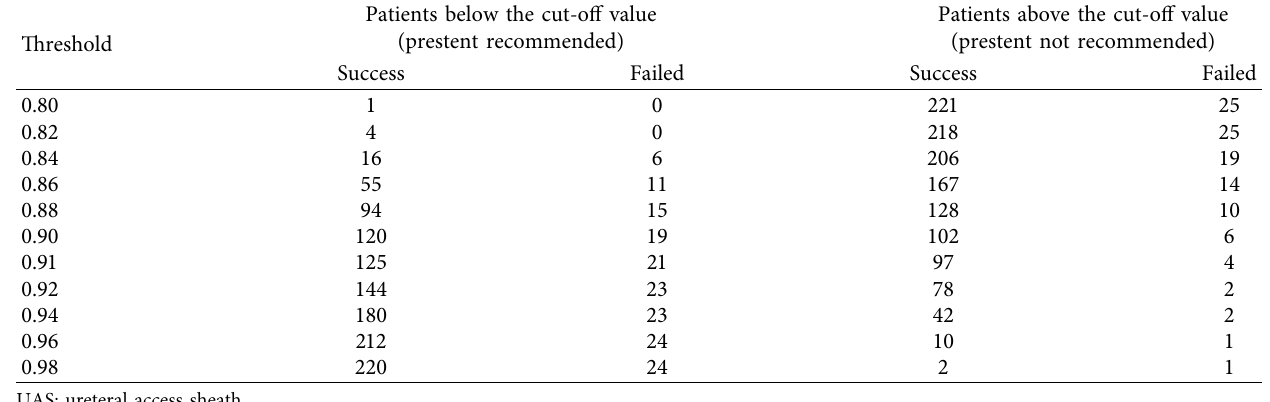
Table 2: Systematic analyses of the nomogram-derived cutofs used to discriminate between patients who received successful or failed UAS placement.